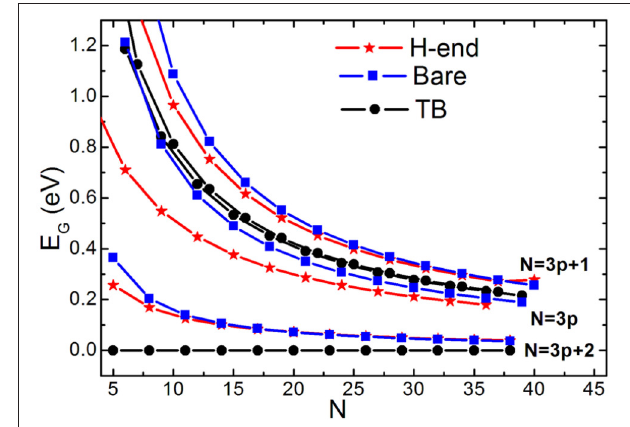
FIGURE 6 | E G vs. ribbon width (N) of the in bare and H-end AGNRs calculated by TB and BOLS-HM. Reprinted with permission from Zhang et al.